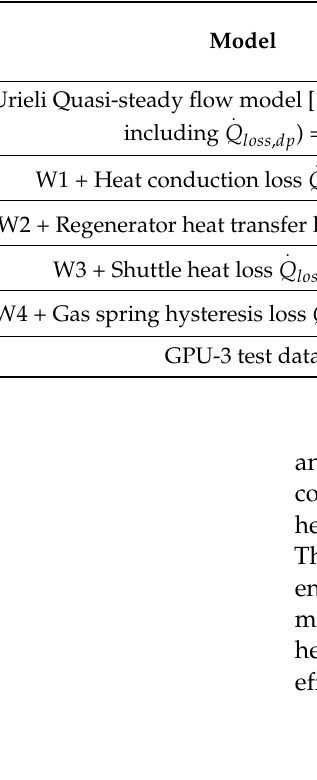
Table 2. Comparative validation of LQSFM with GPU-3